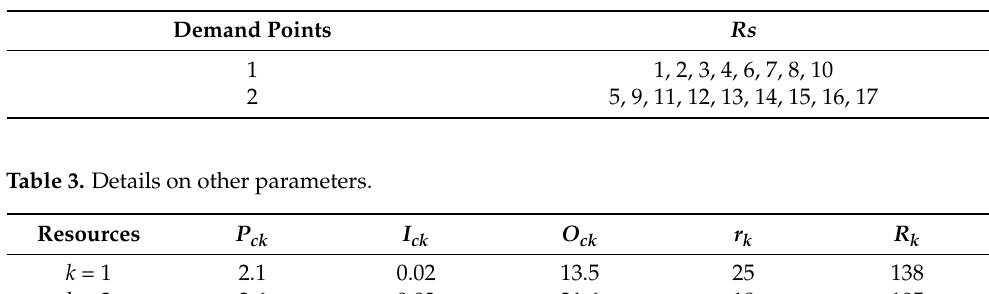
Table 2. Demand point-project activity mapping table.